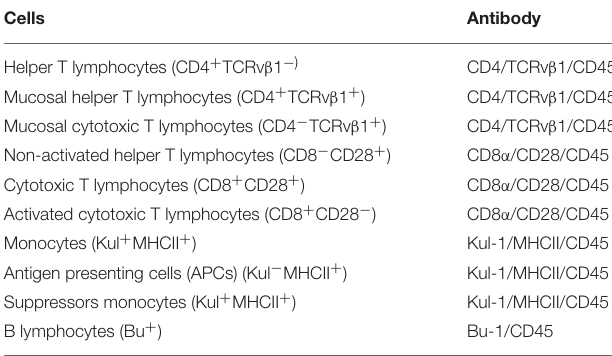
TABLE 1 | Composition of the experimental diets and calculated nutrient composition. Ingredients, %